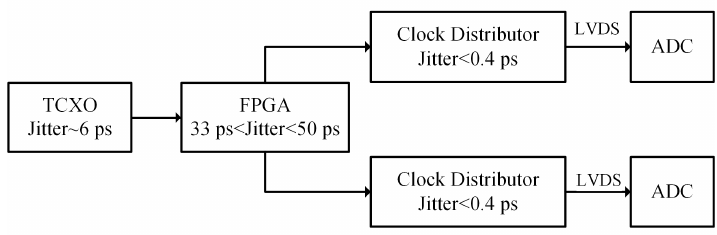
Figure 7. Conventional clock link. (TCXO is temperature compensation crystal oscillator, FPGA is field programable gate array, LVDS is low ‐ voltage differential signaling.).